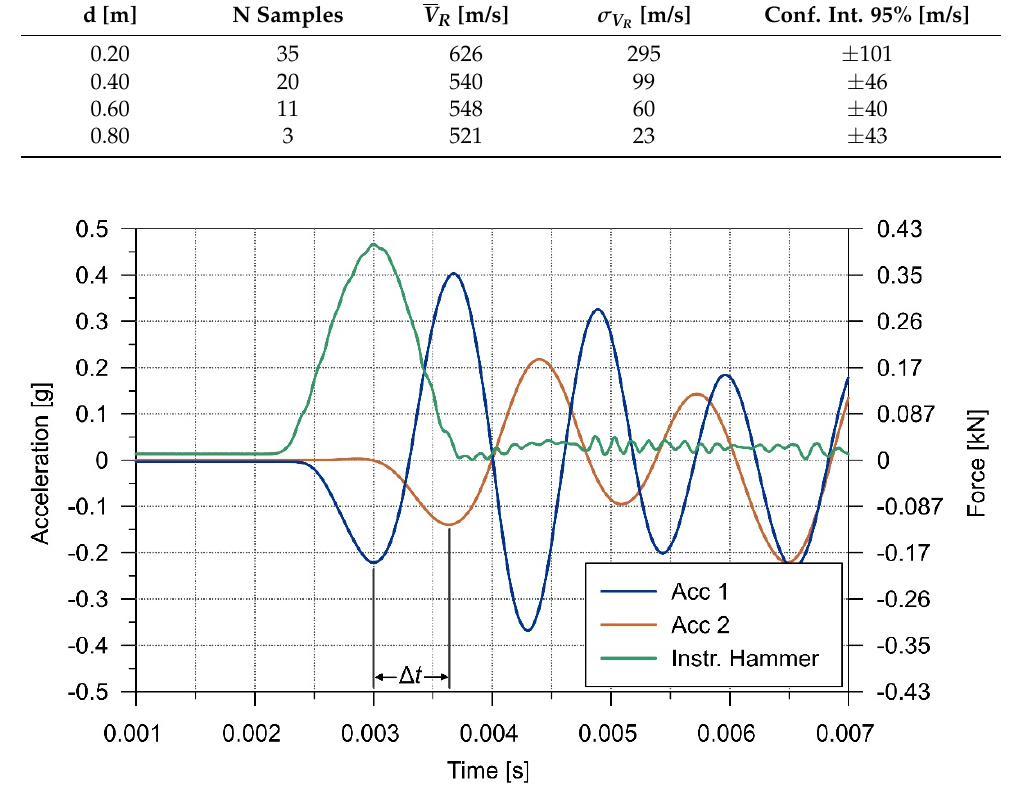
Figure 10. Typical values recorded by the accelerometers in the indirect tests on the masonry panel. Table 2. Indirect impact tests results: distance between the measurement points d ; number of suita- ble samples used in the analysis; mean of R-waves velocity 𝑉(cid:3364) (cid:3019) ; standard deviation of R-waves ve- locity 𝜎 (cid:3023) ; interval of R-waves velocity with a confidence level of 95%. (cid:3267)